Question: What form of chart is displayed?
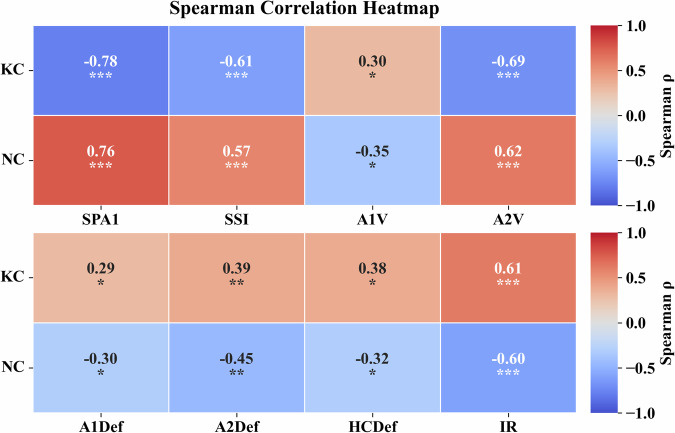
Answer: heatmap